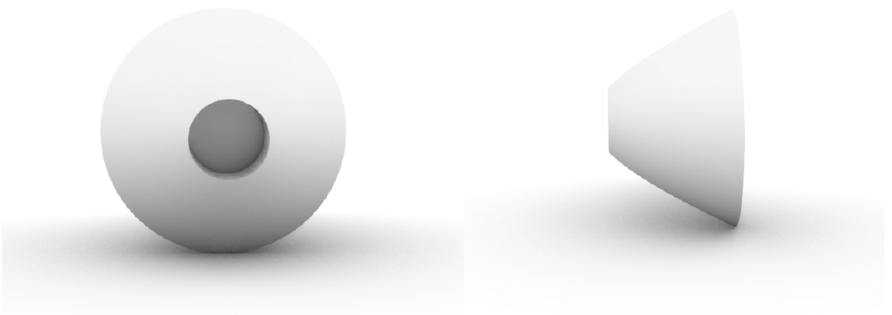
Figure 8. 3-D view of the TIR lens.